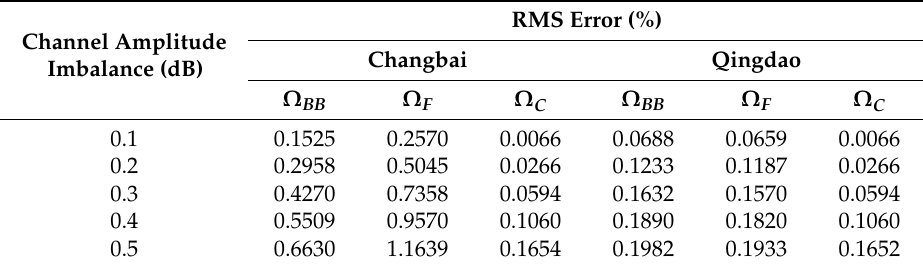
Table 7. RMS error ( σ RMS ) under the condition of channel amplitude imbalance.